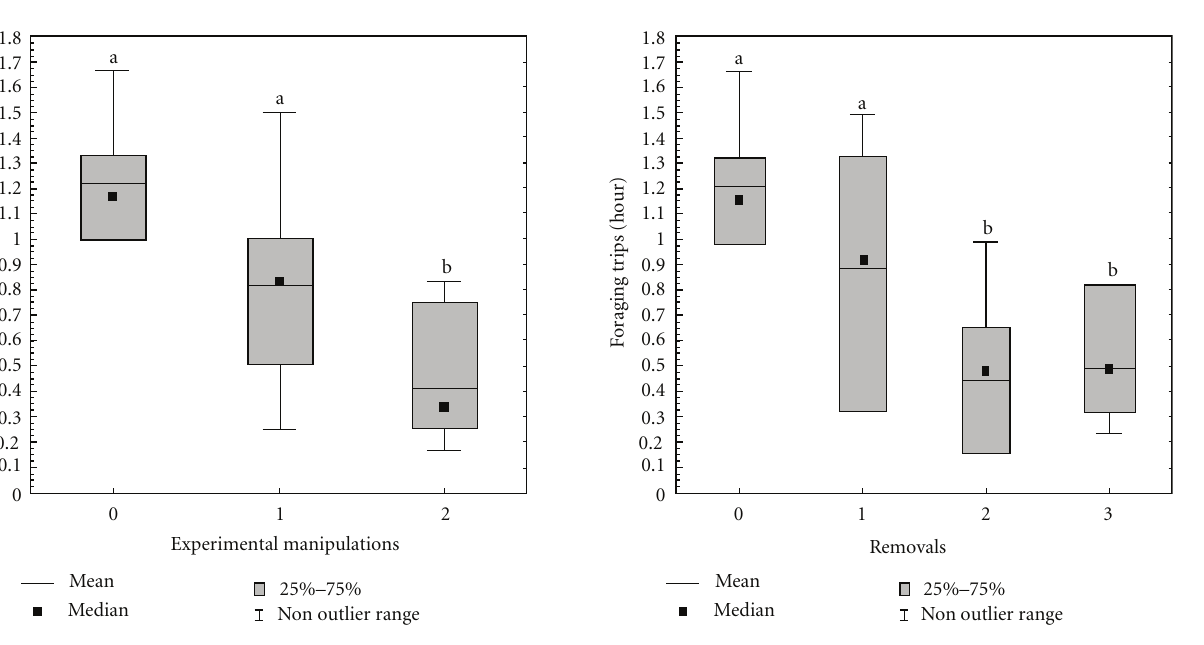
Figure 1: Box-plots indicating the means, median, 25th and 75th percentiles and non-outlier range of the data set used to compare the e ff ect of the removals of females according to the hierarchical position. When compared with the control (0), only the removal of higher-ranked females decreased significantly the foraging activity of Mischocyttarus cerberus styx (0: no manipulation; 1: removal of lower-ranked females and 2: removal of higher-ranked females). Statistical significance at the level of 0.05.